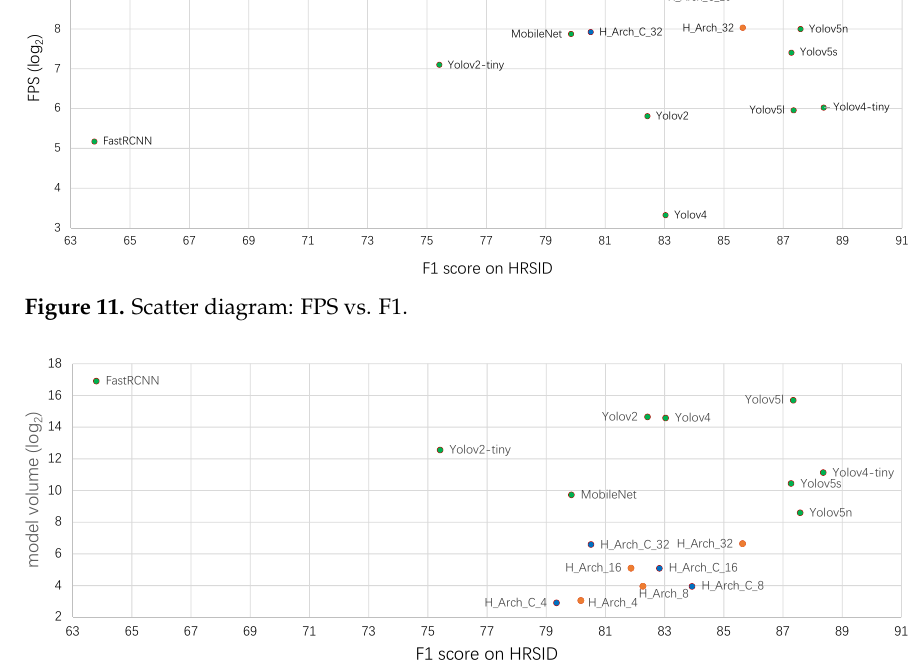
Figure 12. Scatter diagram: model volume vs.